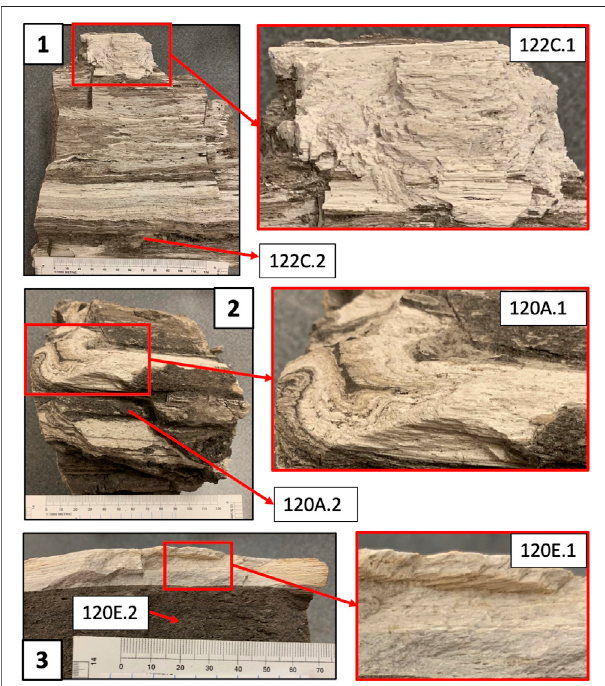
FIGURE 4 | Samples VS20-122C (1), VS20-120A (2), and VS20-120E (3), with an analyzed separates that turned out to be an accidental physical mixtureoftwohigh-silicarhyolitecompositionsintheseparationprocess.This was determined after preliminary observations in the geochemical data combined with reexamination of the hand sample photos taken prior to